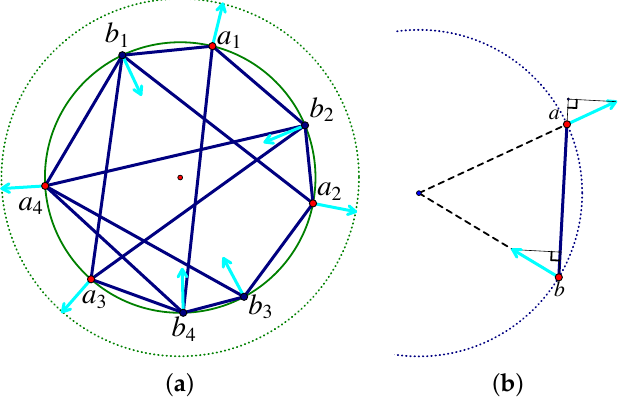
Figure 22. A complete bipartite framework on a circle has a non-trivial infinitesimal motion moving a i out along rays and b j in along rays ( a ). The two velocities for any pair of points on the circle have equal projections on the line of the chord ( b